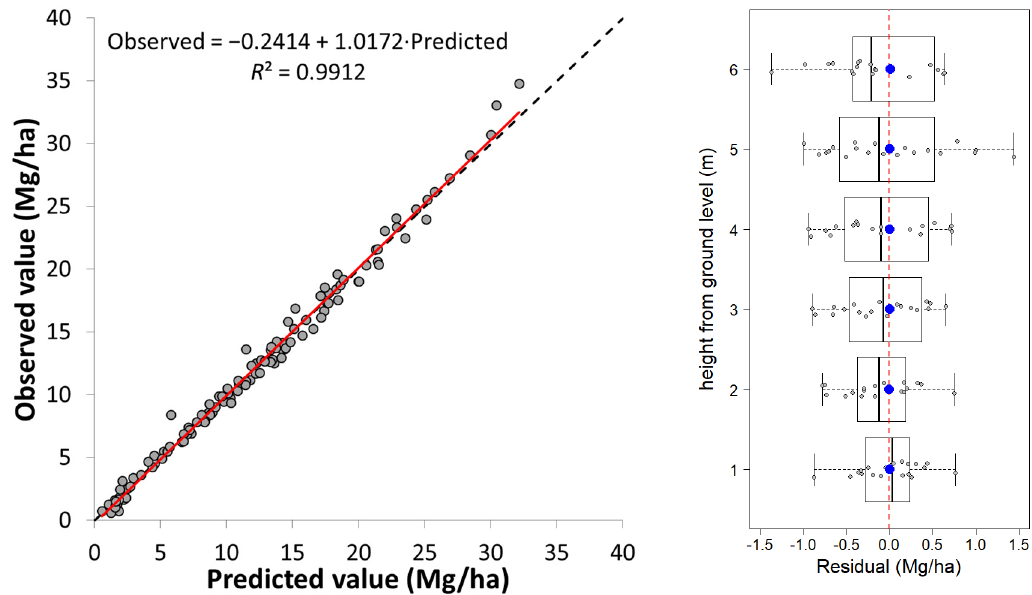
Figure 4. ( Left ) Scatter plots of observed versus predicted values for the vertical distribution of needles ( Wstand acum_needlesj , upper), woody fine ( Wstand acum_G 1 j , middle), and total ( Wstand acum_totalj , lower) stand fuel loads. The solid red line denotes the fitted linear model and the dashed line denotes perfect agreement. ( Right ) Box plots of the vertical distribution of residuals of needles ( Wstand acum_needlesj , upper), woody fines ( Wstand acum_G 1 j , middle), and total ( Wstand acum_totalj , lower) stand fuel loads according to heights from ground level. Blue dots denote the mean values.